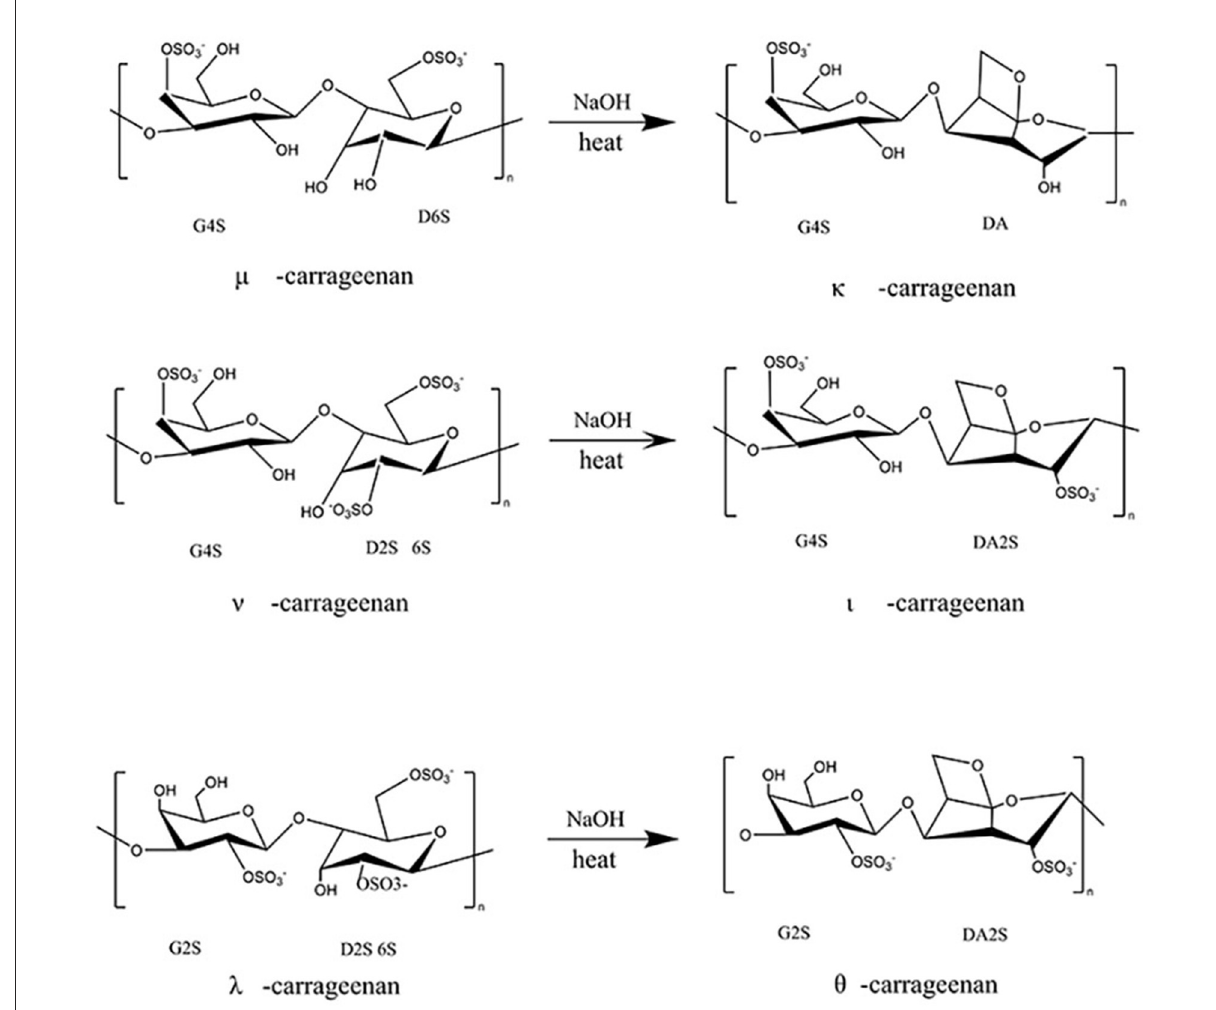
FIGURE3 Conversion between different types of